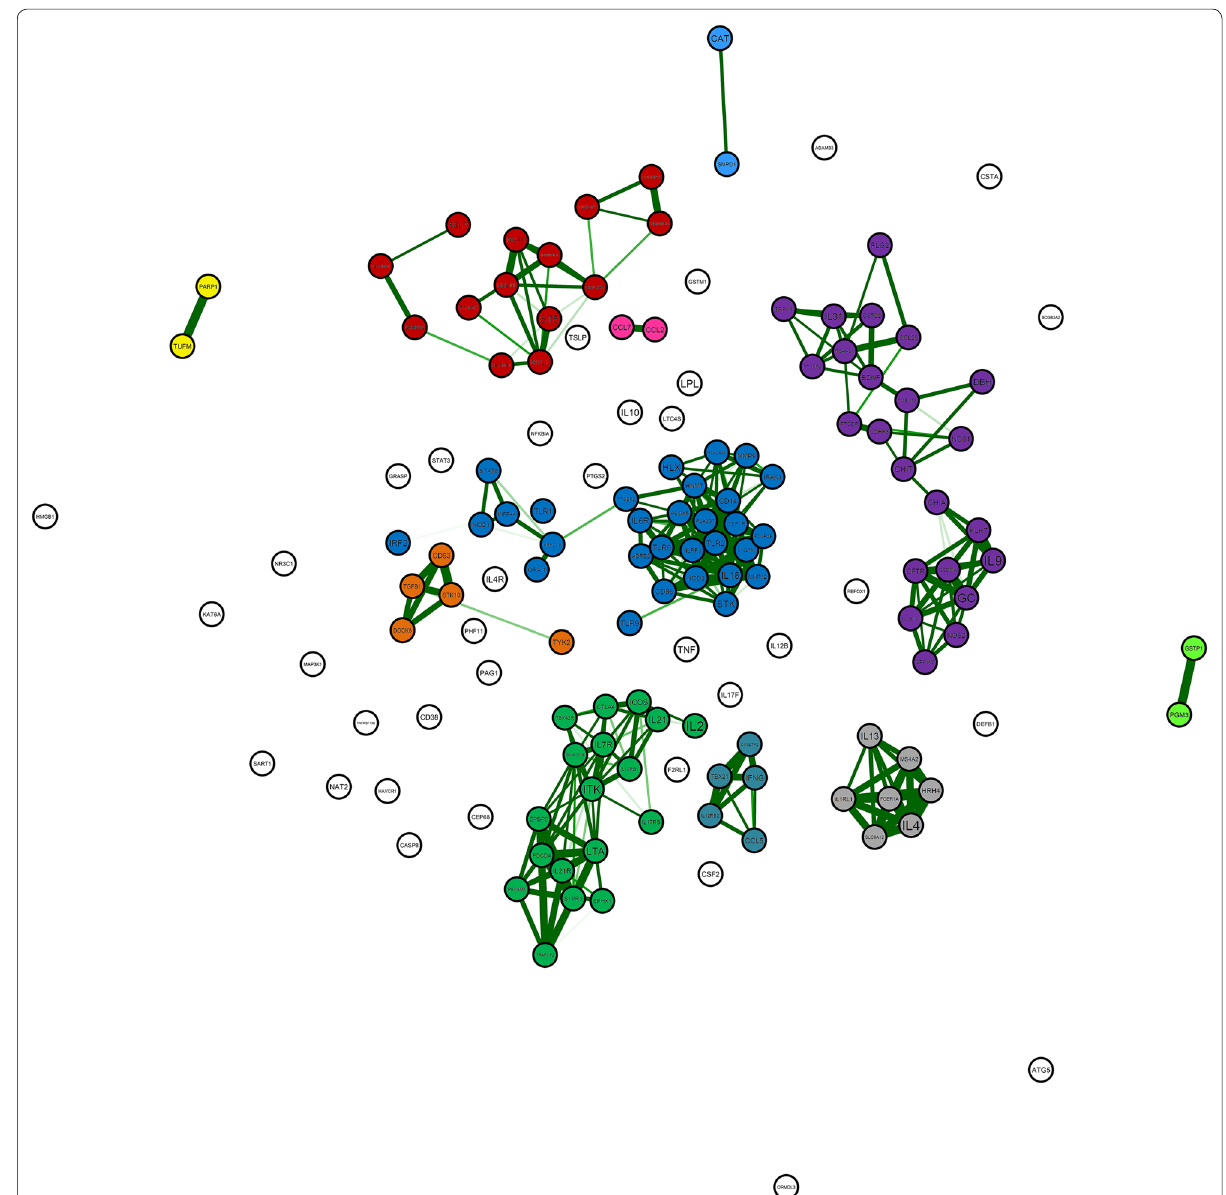
Fig. 2 Genetic correlation network plot of atopy-related gene clusters. The line width between the atopy-related genes indicate the overlay in the top 40 co-expressed gene lists per atopy-related gene and is proportional to the strength of correlation within the clusters. Only those with correlation coefficients > 0.65 are